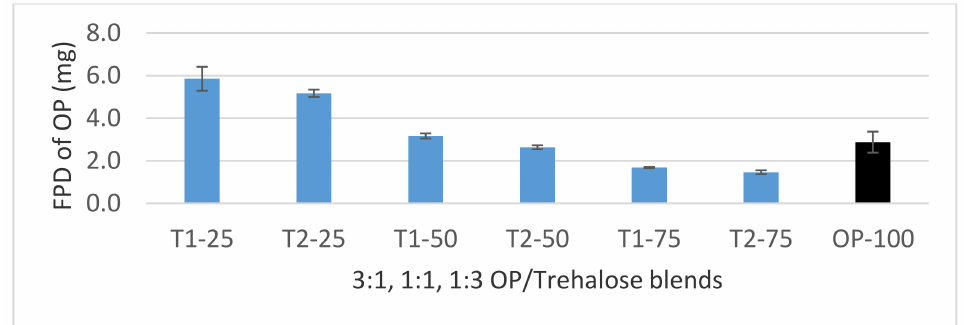
Figure 8. FPD chart of 3:1, 1:1, and 1:3 OP / trehalose blends and diluent free formulation (OP-100) (black bar) aerosolized by the UNI-haler. Blends (blue bars) are arranged according to the trehalose grade and ratio from left to right; 25% micronized trehalose (T1-25), 25% milled trehalose (T2-25), 50% micronized trehalose (T1-50), 50% milled trehalose (T2-50), 75% micronized trehalose (T1-75), and 75% milled trehalose (T2-75). Error bars based on calculated standard deviation from mean ( n =